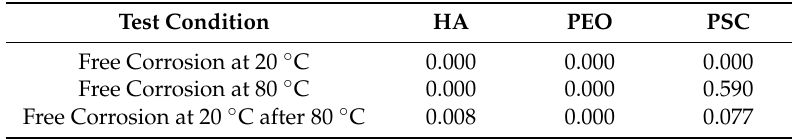
Table 2. Al 3+ (in grams) detected from 3.5% NaCl solution after 24 h free corrosion test.